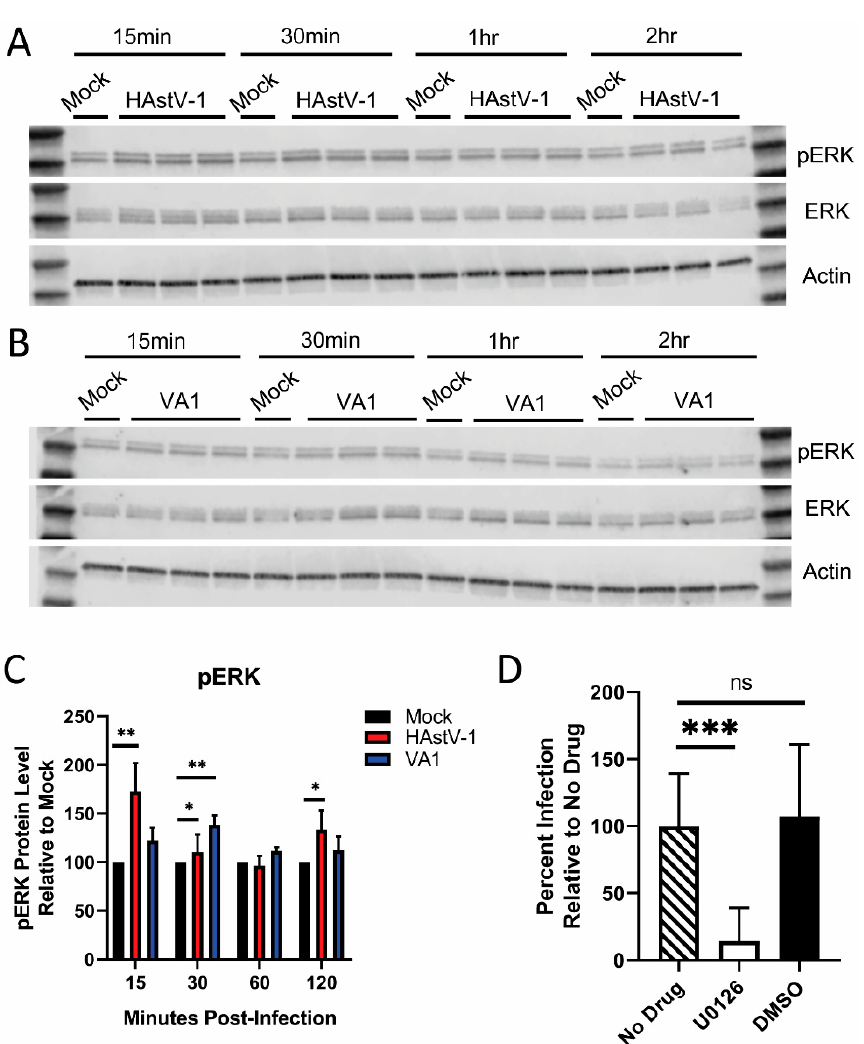
Figure 3. ERK1/2 is activated by VA1 and required for productive replication. Lysates from HAstV-1 ( A ) and VA1 ( B ) infected cells taken at the indicated times post-infection were blotted and probed for pERK, ERK, and β -actin. ( C ) Bands were then quantified by densitometry and normalized to β -actin then compared to mock-infection. ( D ) Caco-2 cells were pre-incubated 10 µM U0126 vehicle alone (DMSO) and then infected with VA1 (MOI of 2). Percent infection was measured by immunofluorescent staining for VA1 capsid at 24 hpi. Error bars indicate standard deviations from two independent experiments performed in triplicate, and asterisks show statistical significance as measured by ordinary one-way ANOVA as follows: *, p < 0.05; **, p < 0.01; ***, p < 0.001.